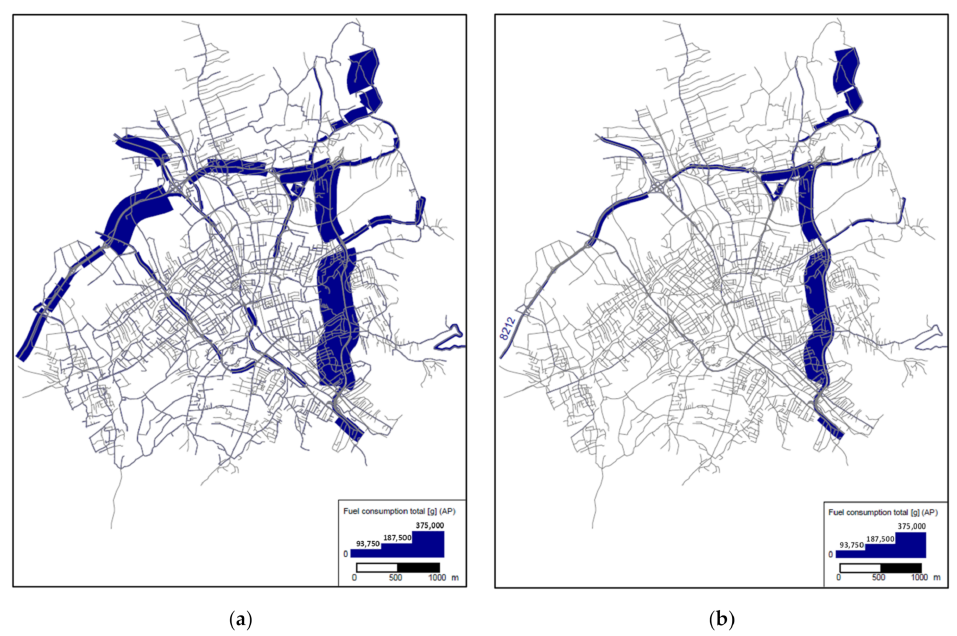
Figure 10. The assessment of fuel consumption total [g] (measure from Group 2) for scenario W0 and optimal scenario (W4)—analysis for the whole city: ( a ) measure for scenario W0; ( b ) measure for scenario W4.